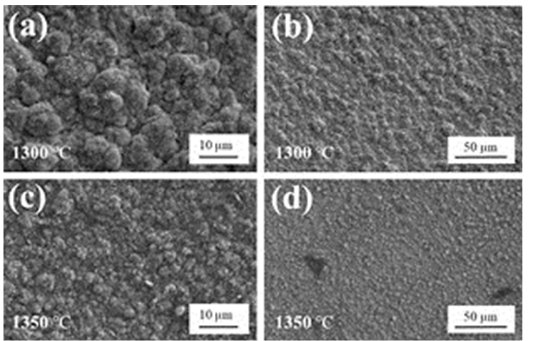
Figure 4. Surface morphology of HfO 2 coatings prepared at different deposition temperatures. ( a ) 1300 °C, ( b ) 1300 °C, ( c ) 1350 °C, and ( d ) 1350 °C.